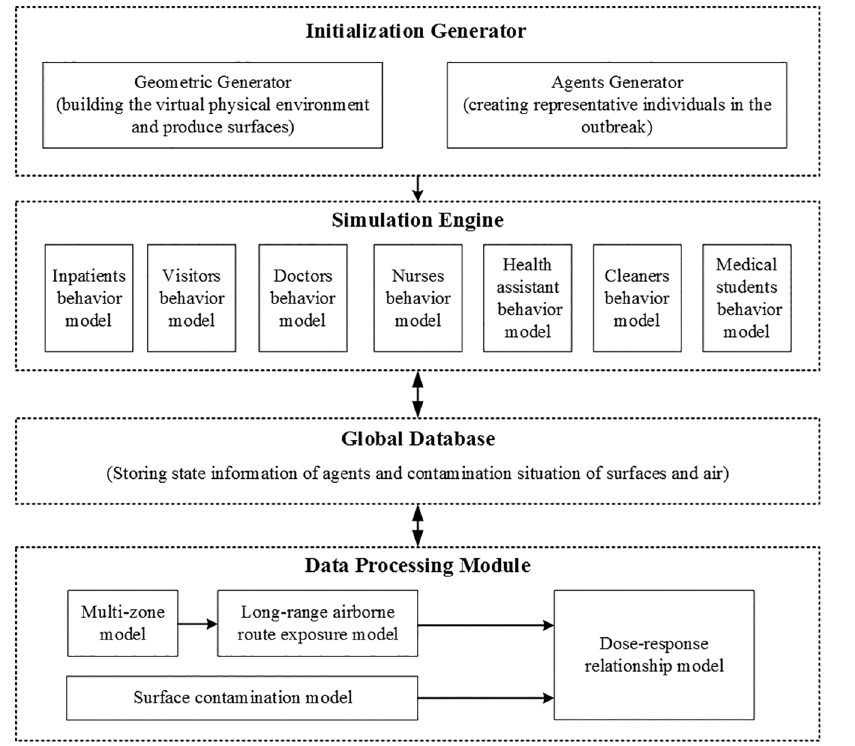
Fig 2. System architecture of the multi-agent